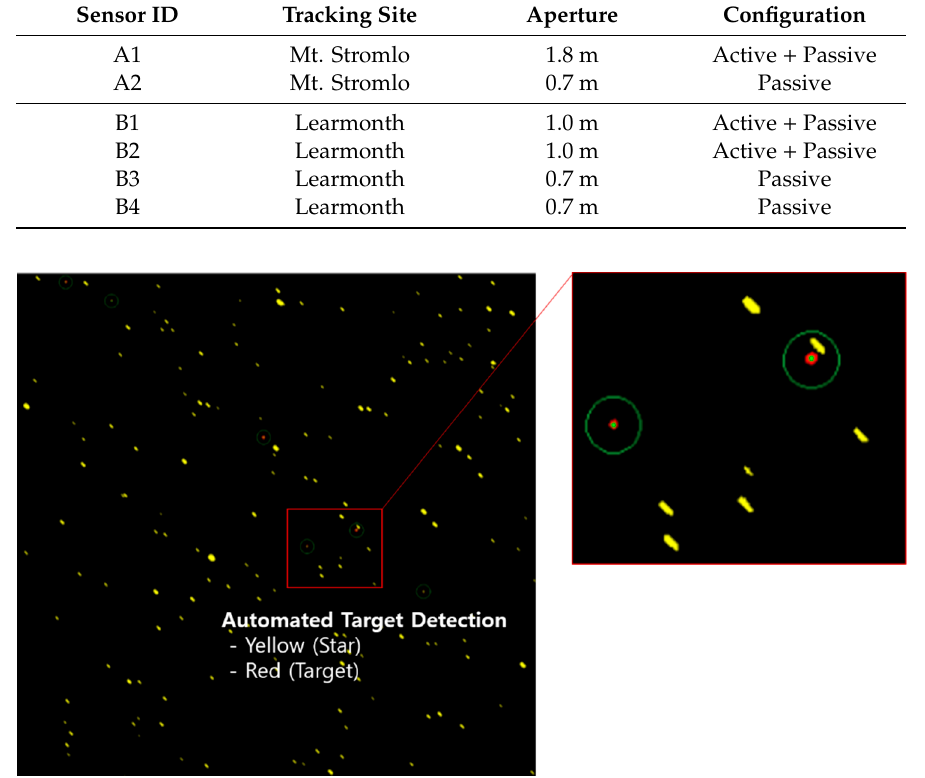
Figure 3 . The image of automated target detection in the deep space observation [15]. Figure 3. The image of automated target detection in the deep space observation